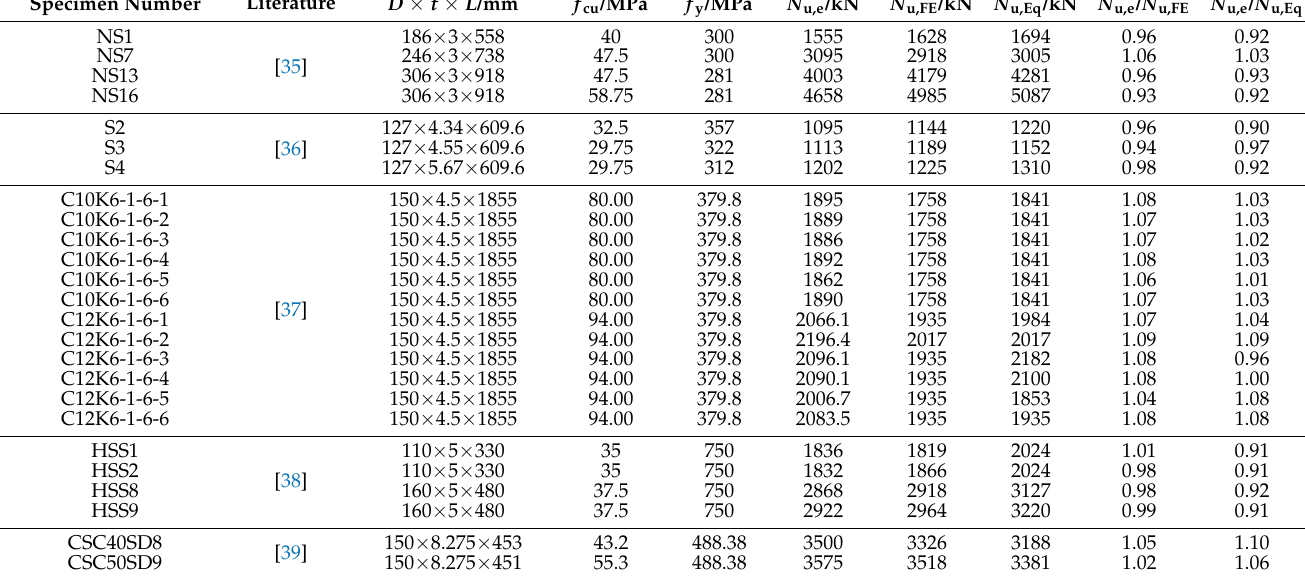
Table A1. Comparison between finite element calculation results and literature experimental results of high-strength concrete-filled square steel tube stub